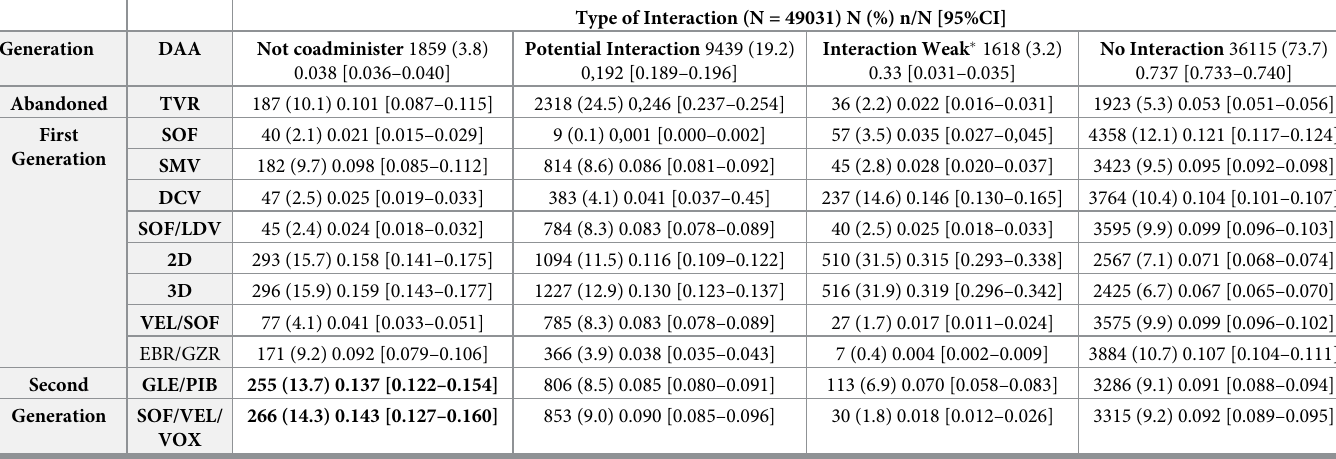
Table 3. Distribution of the interactions found according to the scheme